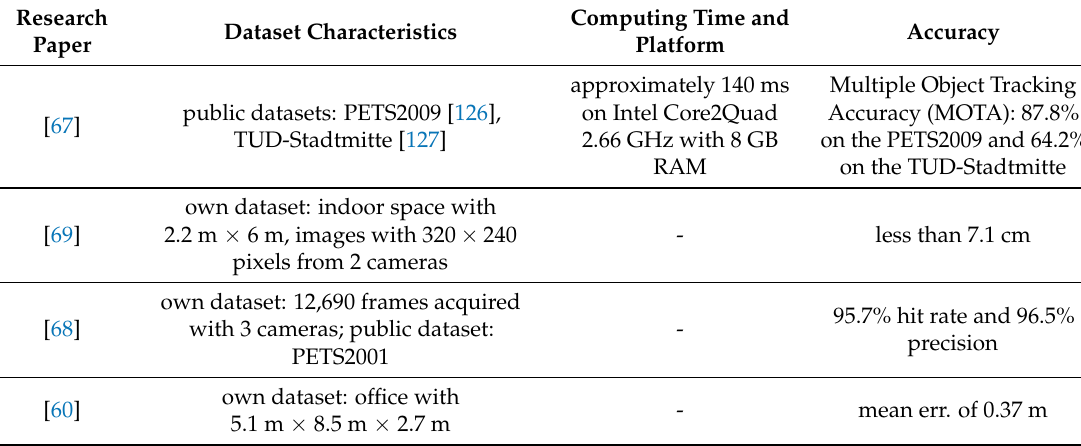
Table 3. Characteristics of indoor localization solutions with 2D static cameras (with known positions), real features, and traditional image